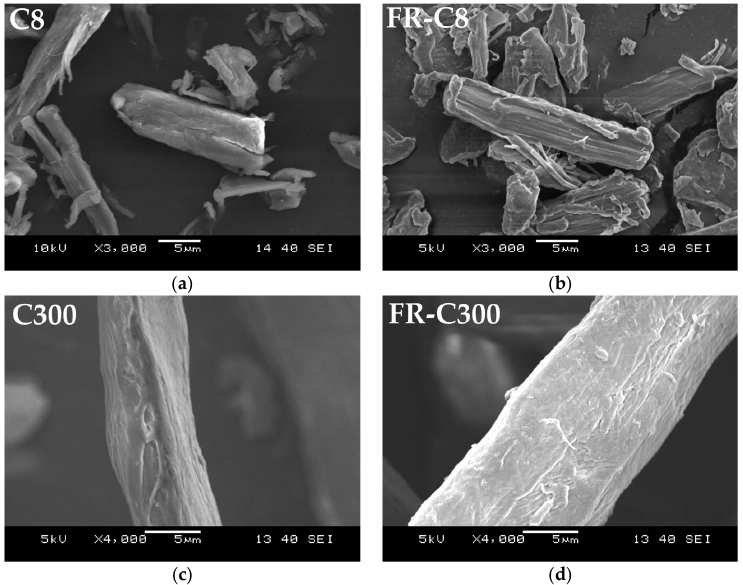
Figure 3. SEM images of the ( a ) Untreated C8 additive; ( b ) FR-treated C8 additive; ( c ) untreated C300 additive; ( d ) FR-treated C300